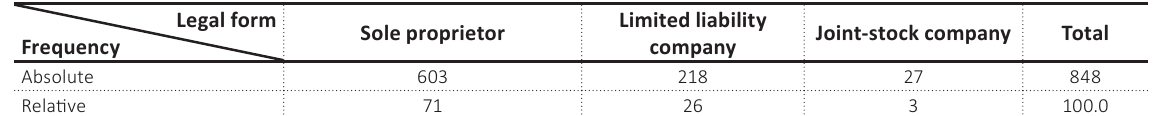
Table 1. Frequency of family businesses by legal form